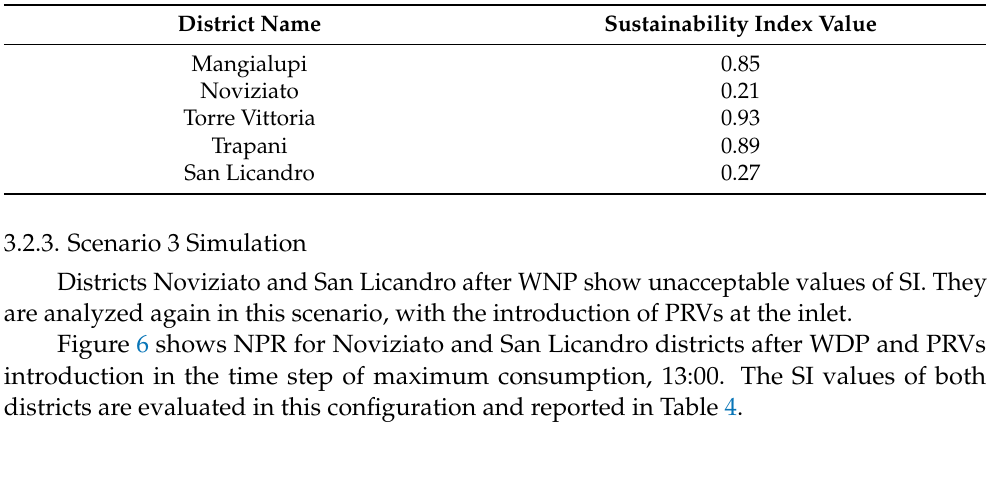
Table 3. SI values for each district in Scenario 2 after